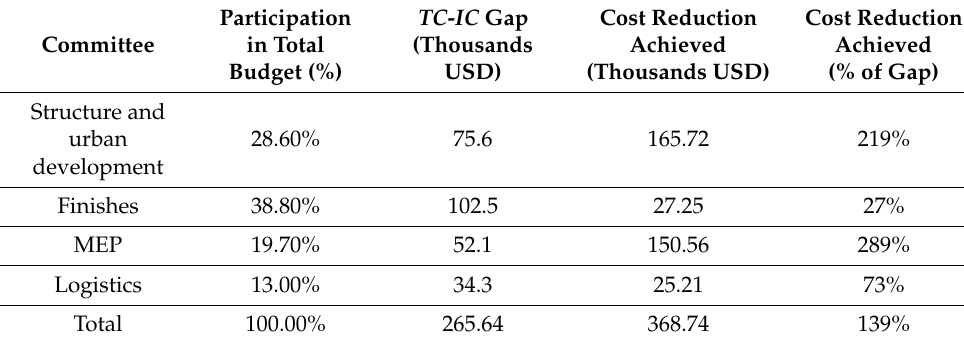
Table 6. Gap distribution among the committees.